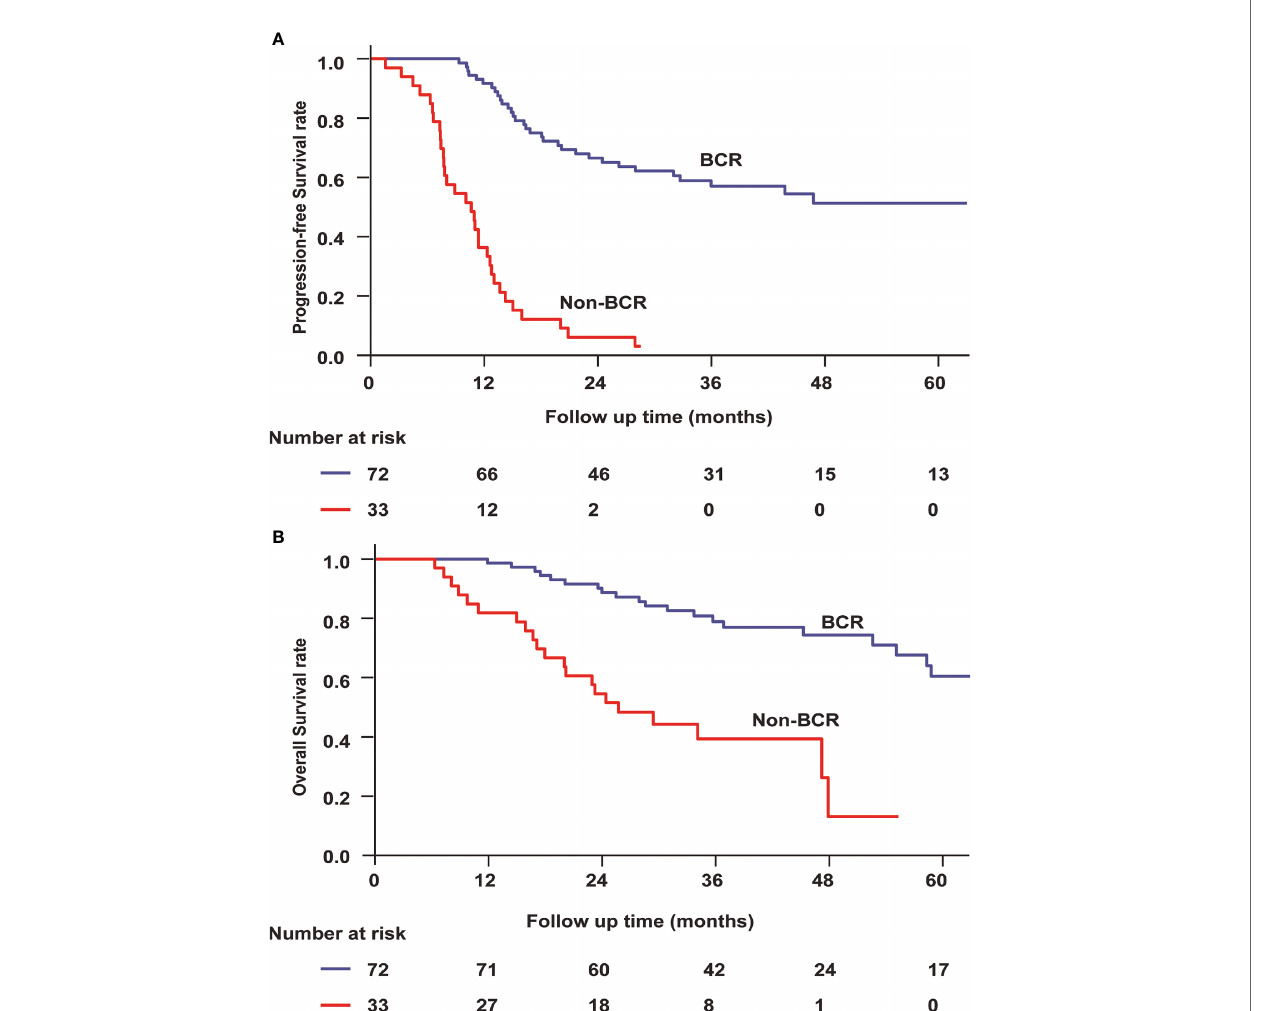
FIGURE 2 | Progression-free survival (A) and overall survival (B) for bone-only metastatic nasopharyngeal carcinoma according to EBV-DNA kinetics. BCR, biochemical complete response.